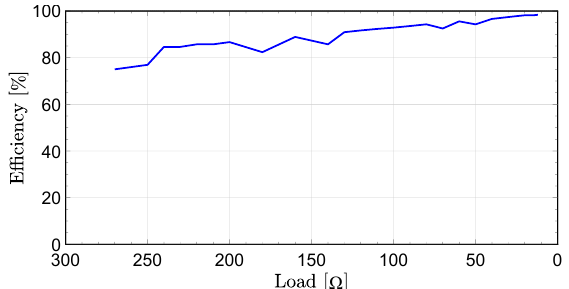
Figure 19. The efficiency Vs loads of the proposed circuit.